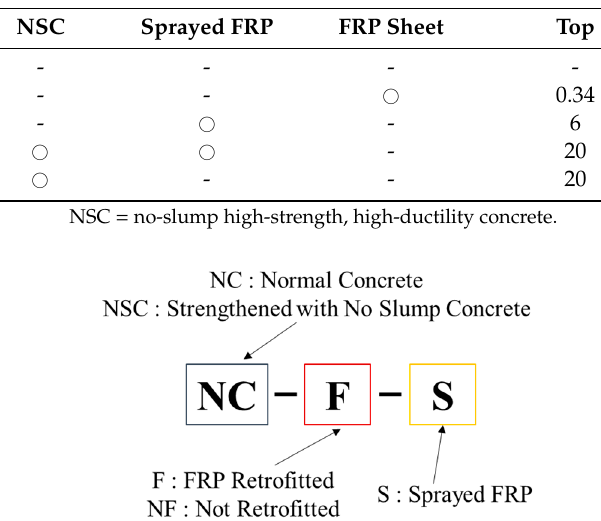
Table 6. Mechanical properties of carbon fiber and